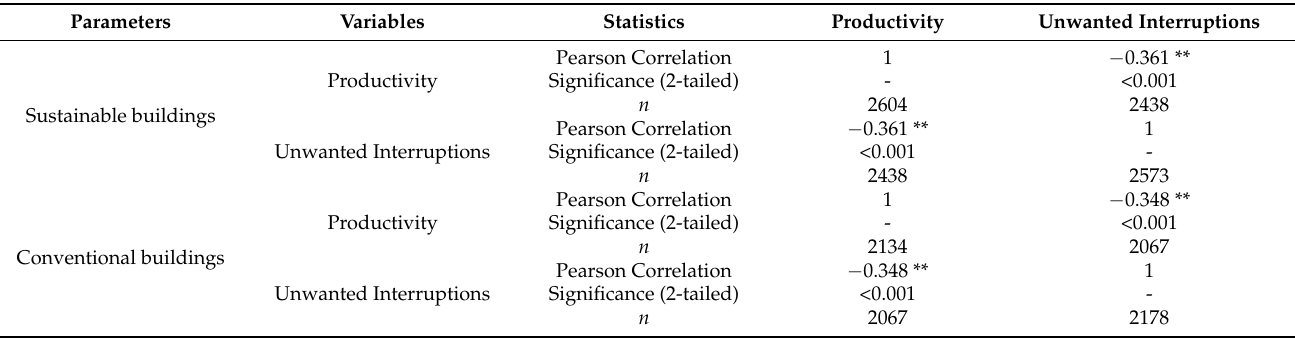
Table 9. Pearson correlation comparing productivity and unwanted interruptions in sustainable and conventional building